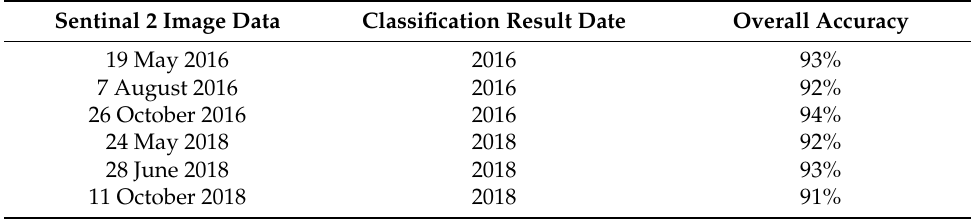
Figure 7. The spatial distribution of sample points in 2016 and 2018. Table 2. Accuracy evaluation of GRNDVI classification results in years 2016 and 2018. Sentinal 2 Image Data